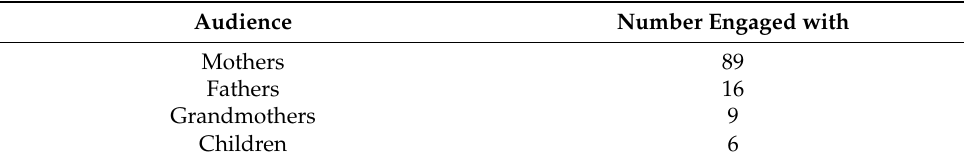
Table 1 details the type and number of participants involved. Table 1. Number of respondents from the different target